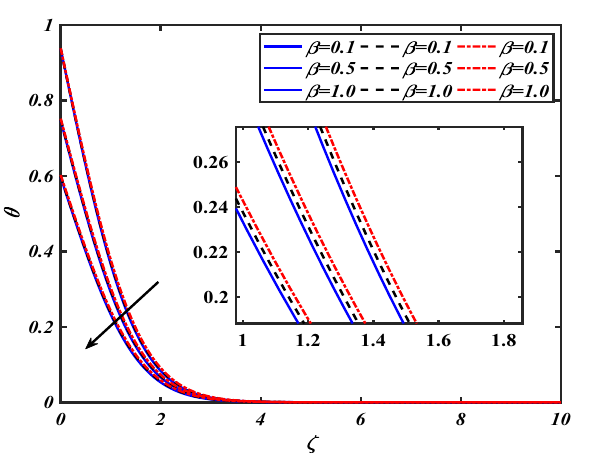
Figure 12. Pictogram of β via θ .